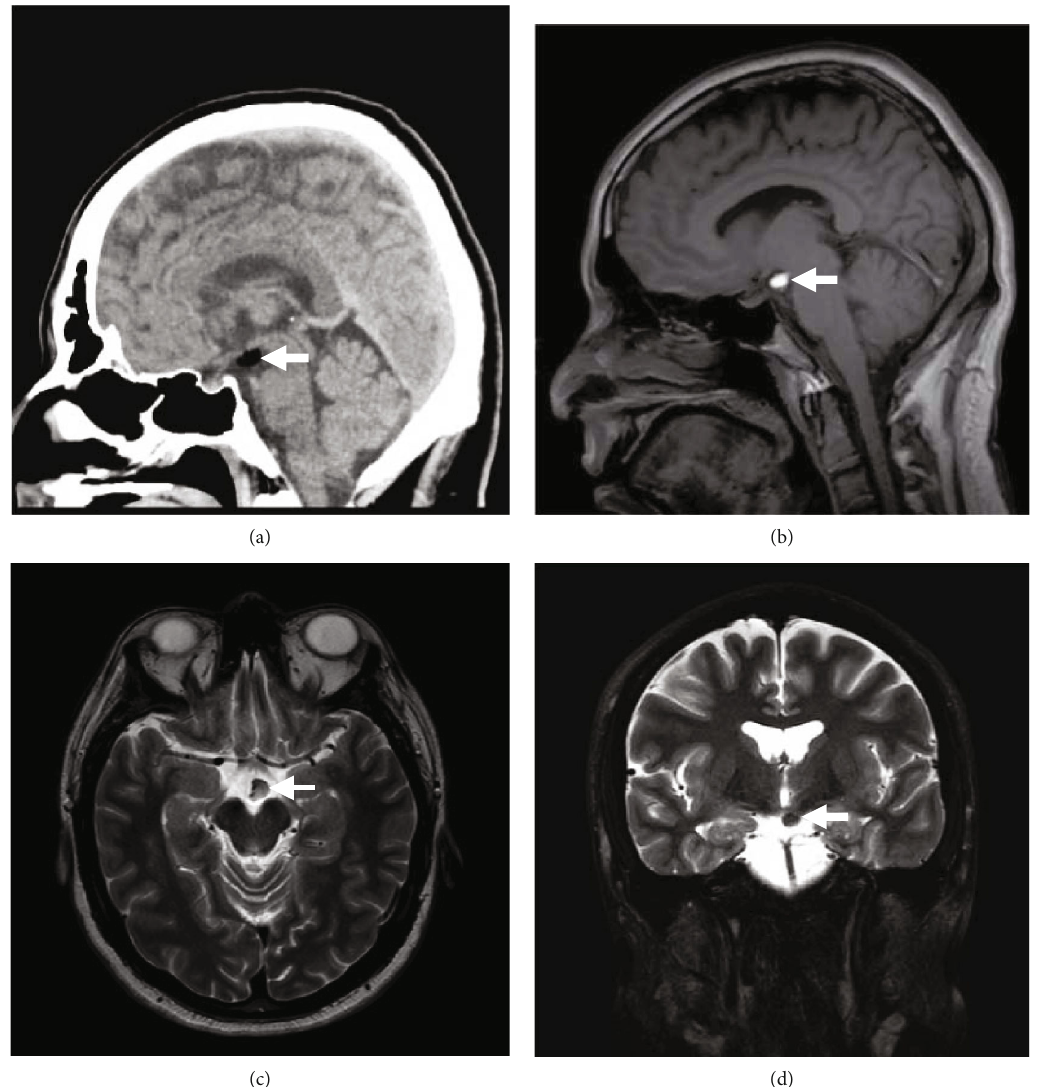
Figure 1: (a) Sagittal brain CT without contrast. (b) Sagittal T1-weighted MRI. (c) Axial T2-weighted MRI. (d) Coronal T2-weighted fat- saturated MRI. (a) – (d) The images demonstrate a homogeneously oval-shaped, fat-containing suprasellar hypothalamic lesion measuring 11 × 7 × 7mm in the anterior-posterior, transverse, and craniocaudal dimensions, respectively, on the left side. The lesion is hyperintense in T1-weighted images, intermediate to hyperintense in T2-weighted images, and suppressed on fat-saturated images. No internal septation, nodularity, or calci fi cations are noted.